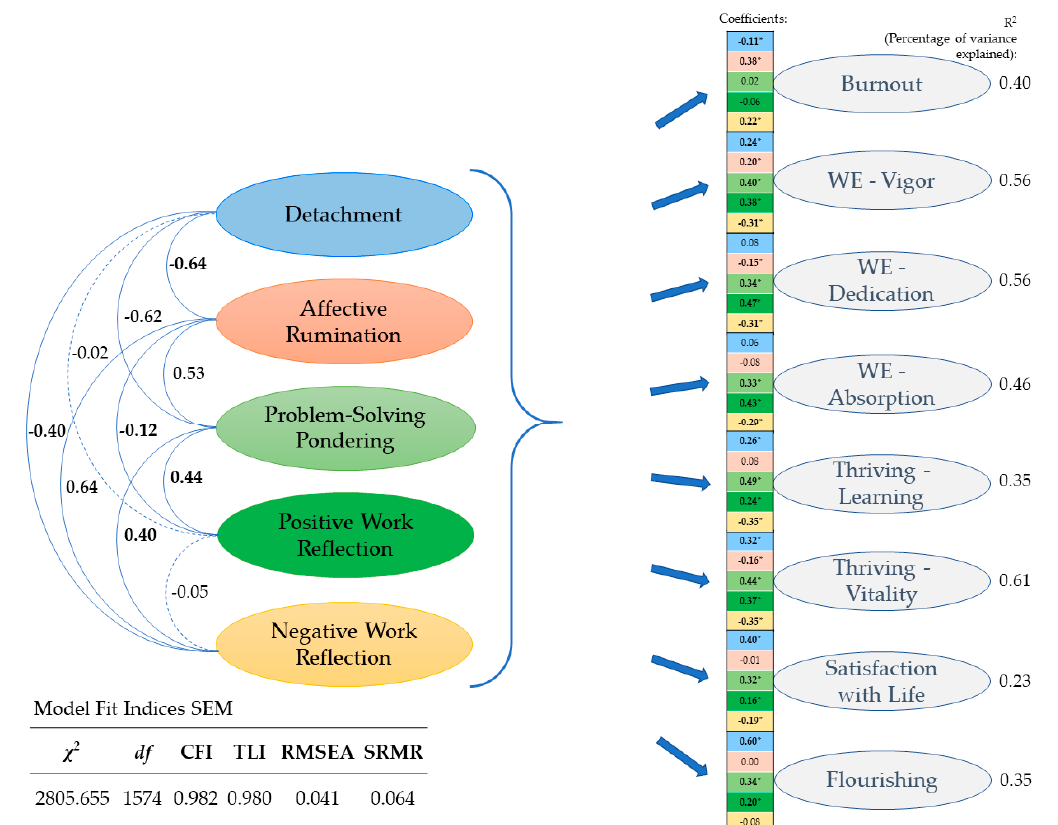
Figure 2. Focal structural equation model linking facets of work-related rumination to facets of employee well-being.